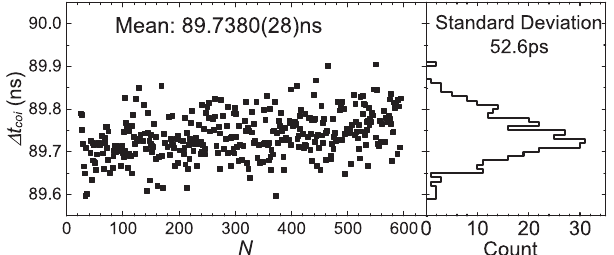
FIG. 3. Time differences, Δ t , as a function of revolution coi number, N , for 342 coincidence timing signals recorded by both TOF detectors in the same revolutions. The data are for the same 45 V 23 þ ion as in Fig.